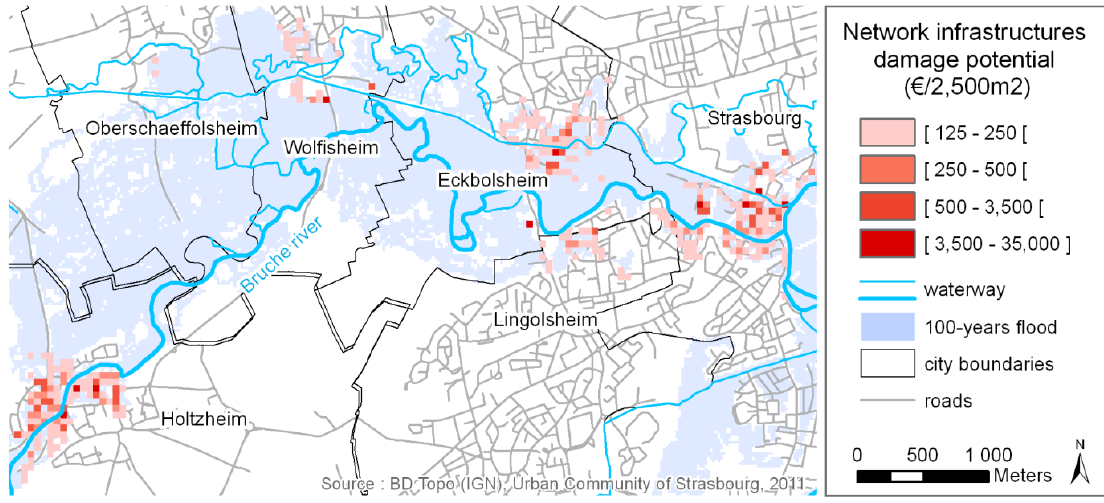
Figure 7. Map of damage costs caused by a 100-year return-period flood on the grouping of the network components analysed: sewerage and drainage, public lighting, gas distribution and power supply.